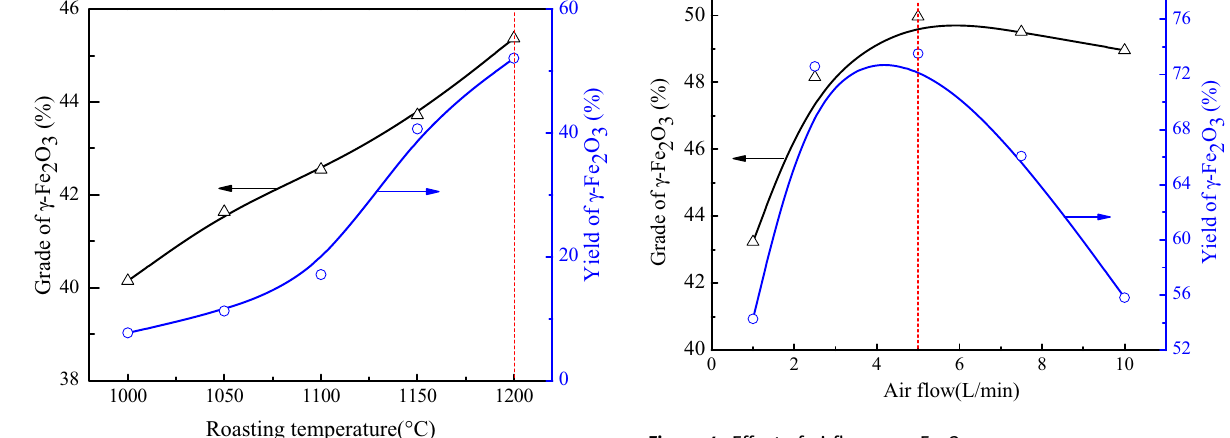
Figure 4: E ff ect of air fl ow on γ - Fe 2 O